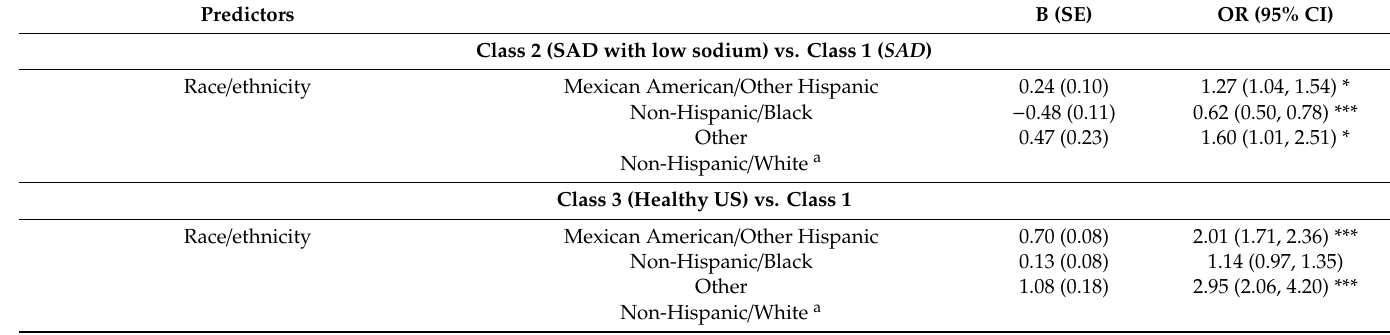
Table 7. Predicting daily dietary patterns (latent classes): multinomial logistic regression of the NHANES 2007–2010 population (age ≥ 19 years, N =